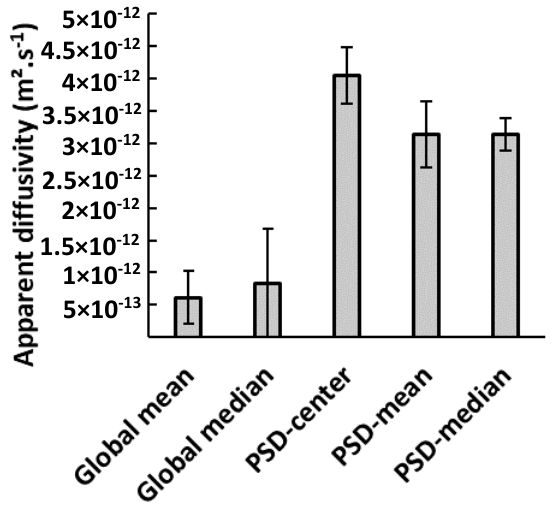
Figure 7. Apparent water vapor diffusivity in cellulose particles estimated for different shape descriptors (bin class of 10 µm × 10 µm).